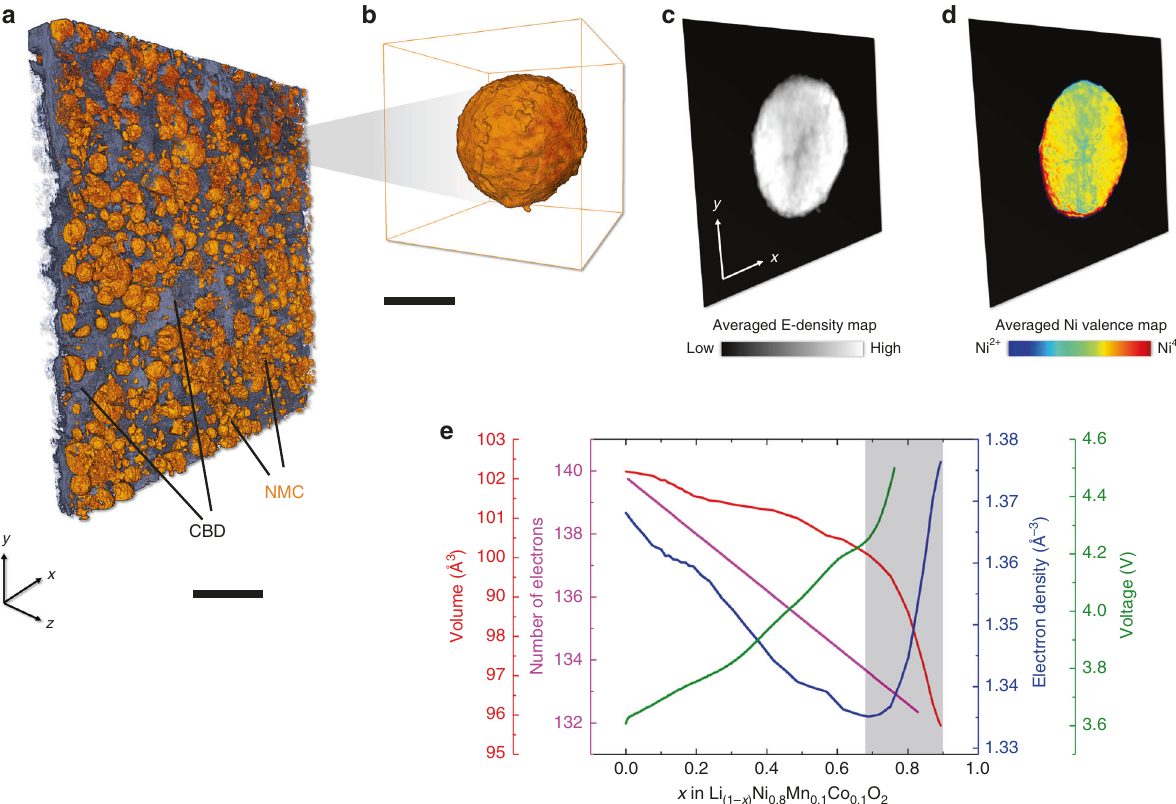
Fig. 5 Electron density as a proxy for the SoC. a The 3D rendering of an electrode with a monolayer of NMC 811 particles. b – d illustrates our correlative approach for imaging the same NMC particle. c The phase contrast image collected at ID16A, ESRF, Grenoble, France. d The spectroscopic imaging data of the same particle collected at 6-2C, SSRL, Menlo Park, CA, USA. e shows the changes of lattice unit cell volume, number of electrons per lattice unit cell, voltage (1 C), and electron density as a function of the SoC. The scale bars in ( a ) and ( b ) are 25 and 5 μ m,